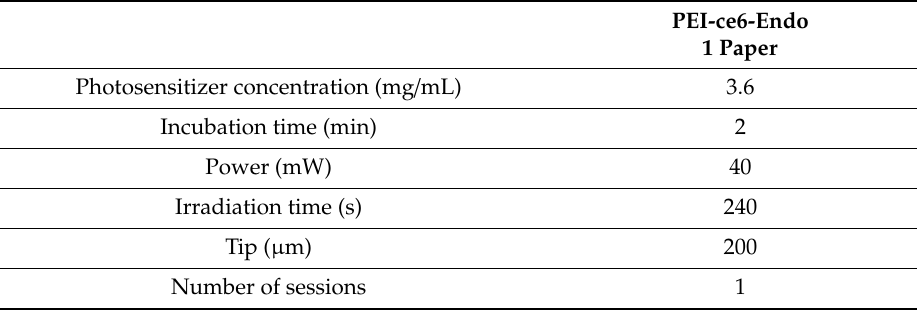
Table 12. Single study with polyethyleneimine and chlorin(e6) conjugate